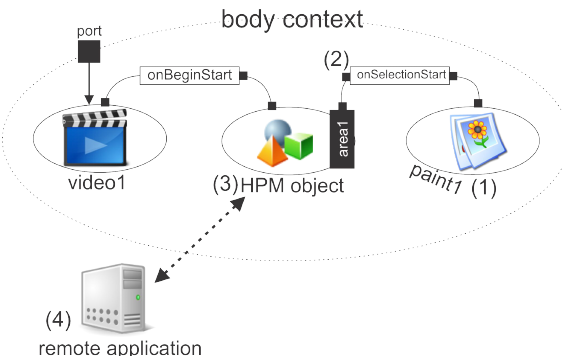
Figure 1. HPM Object in a multimedia